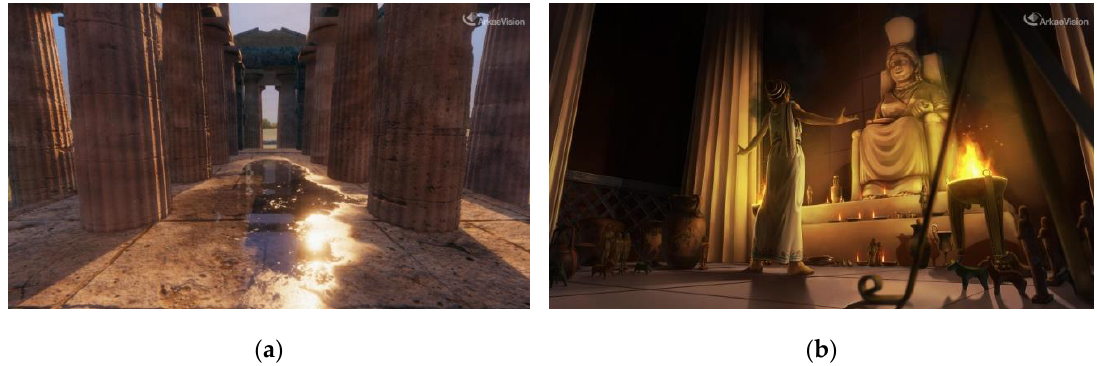
Figure 2. Screenshots taken from the virtual reality (VR) application of ArkaeVision Archeo : ( a ) exterior of the naos in the present day and ( b ) interior of the naos in the fifth century BC with the priestess Ariadne. Copyright © Digitalcomoedia.